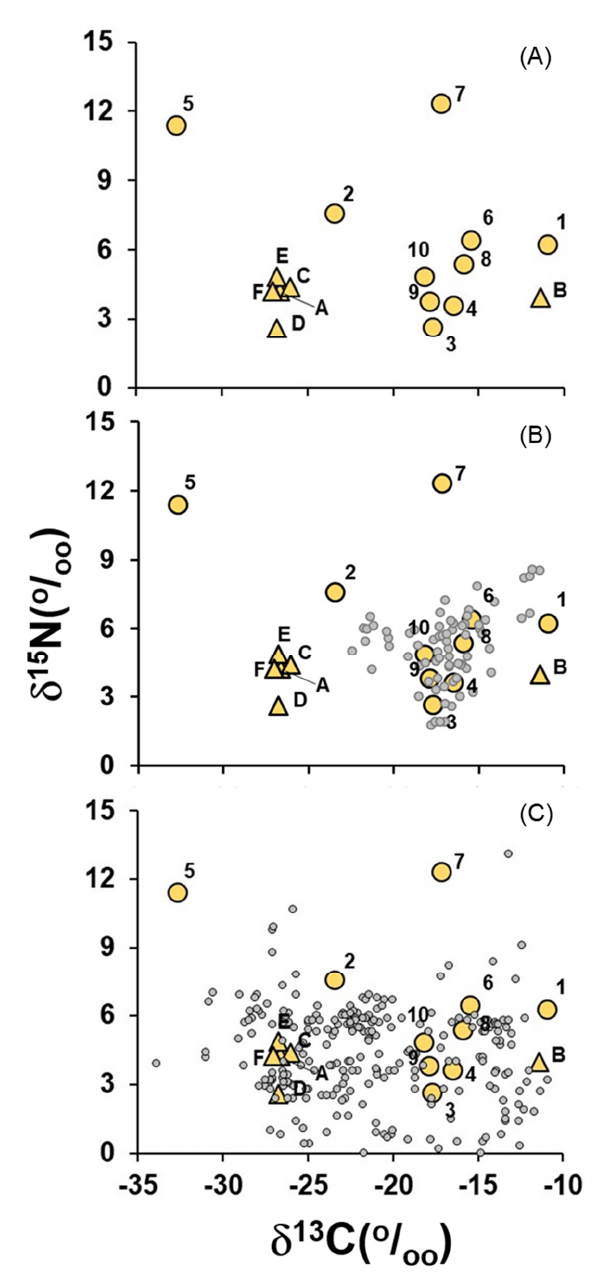
Figure 4. Biplot of δ 13 C vs. δ 15 N of: ( a ) plants (yellow triangle), and animal protein (yellow circle). A: C 3 -cereal; B: C 4 -cereal; C: fruit; D: pulse; E: tuber; F: vegetable. 1: beef; 2: bushmeat; 3: poultry; 4: egg; 5: freshwater fish; 6: lamb; 7: marine fish; 8: milk; 9: pork; 10: farmed fish (tilapia). ( b ) plants (yellow triangle), animal protein (yellow circle), processed food of animal origin (small grey circle). ( c ) plants (yellow triangle), animal protein (yellow circle), processed food of plant origin (small grey circle). In order to facilitate visualization, only processed foods with δ 15 N > 0% (cid:24) were included in ( b , c